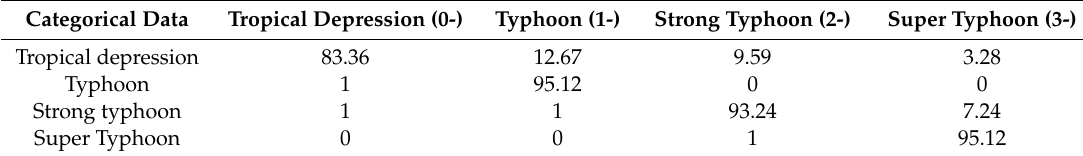
Table 2. Comprehensive evaluation of typhoon level prediction.